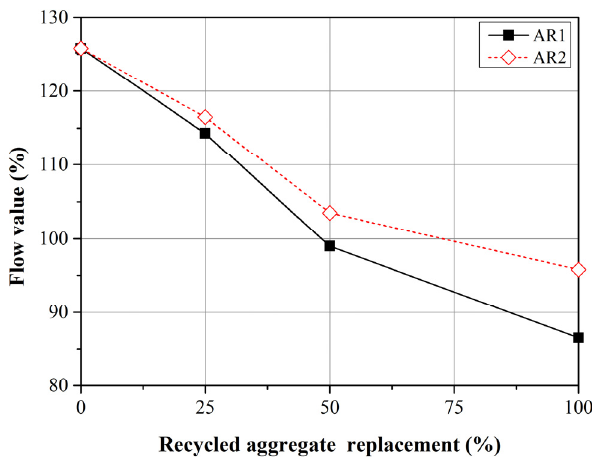
Figure 5. Flow values of mortar with W/C = 0.35.